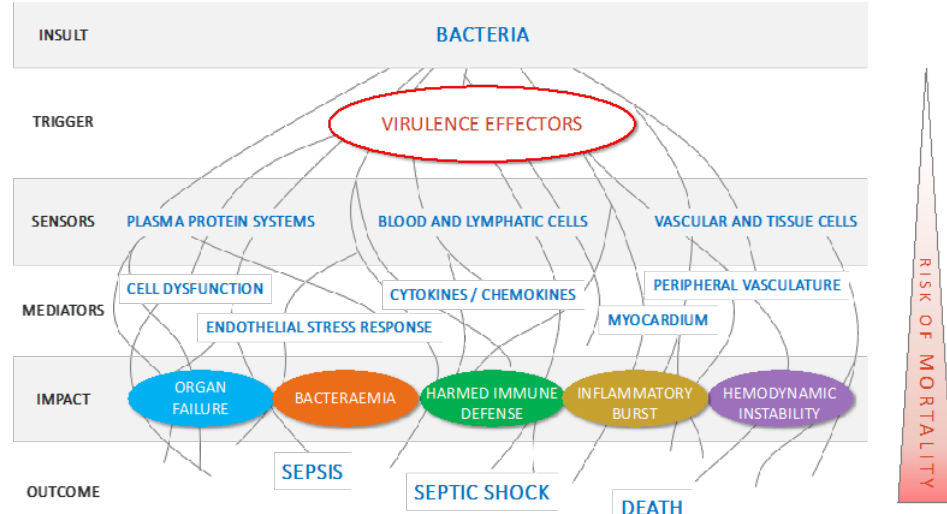
Figure 2. Virulence effectors as essential triggers of pathogenic pathways. Schematic illustration of the upstream role of virulence effectors in triggering multiple pathogenic processes leading to organ failure, sepsis, septic shock and death.